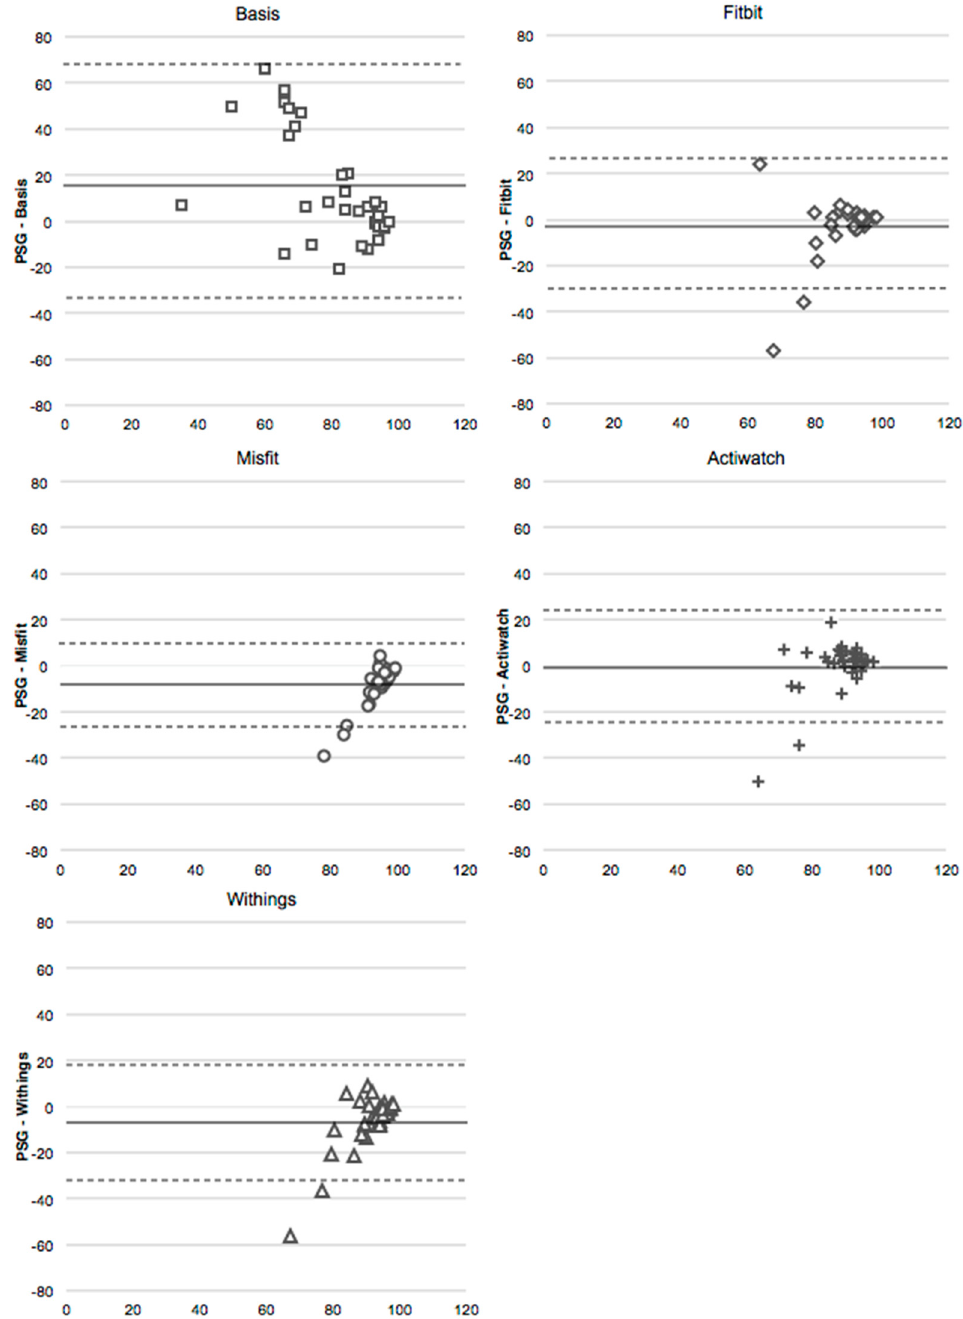
Figure 2. Bland-Altmann plots for sleep efficiency (%) for the Basis, Fitbit, Misfit, Withings, and Actiwatch compared to PSG (adjusted values). The x-axis is the mean of the two devices, and the y-axis represents PSG minus the device. Dotted line represents two standard deviations from the mean.